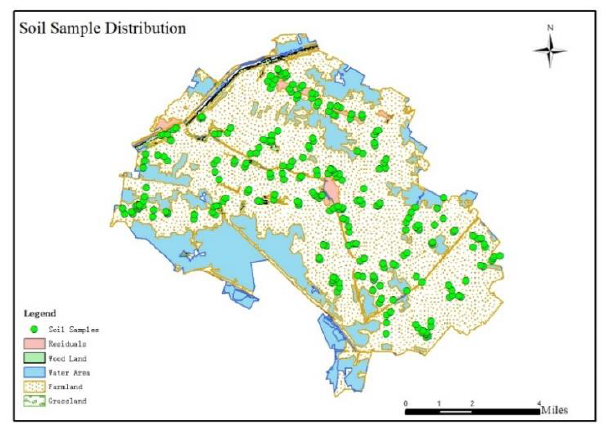
Figure 1. Distribution of the soil